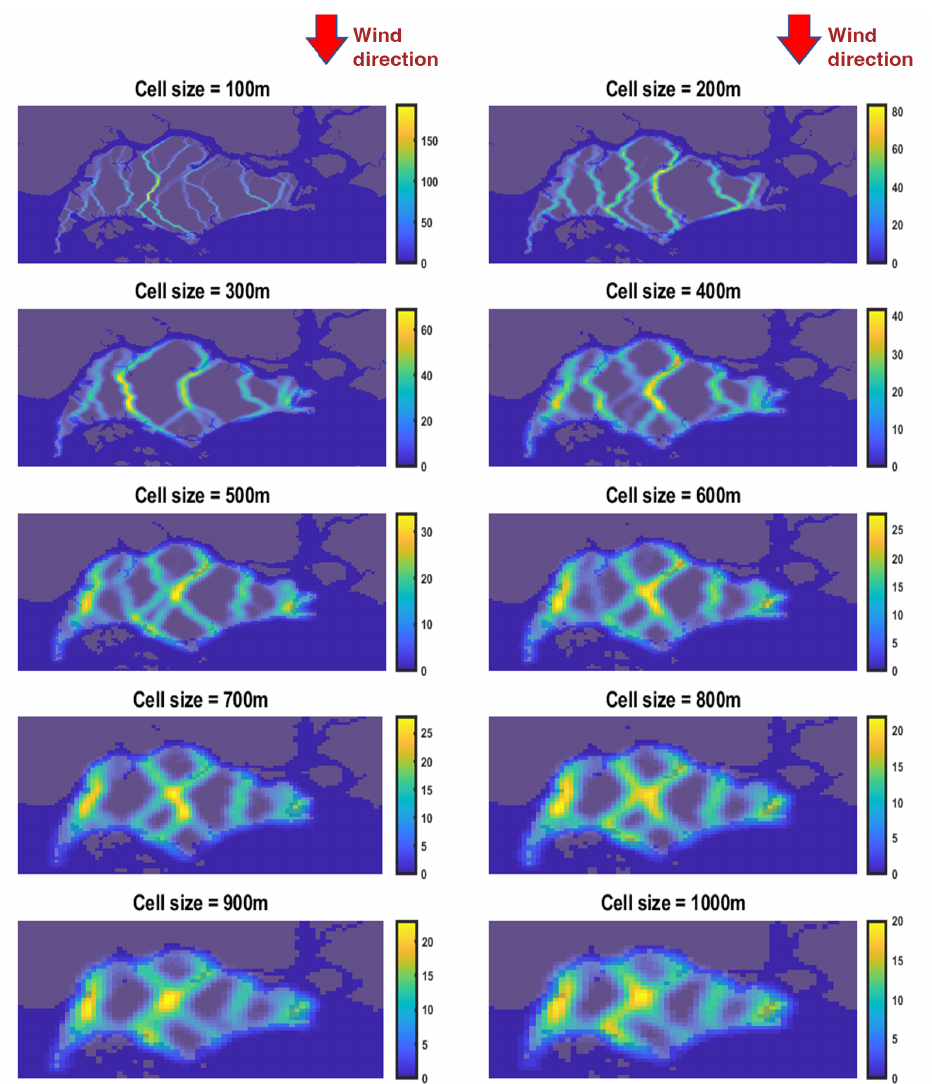
Figure 10. North–south ( θ A = 0) wind corridors for different sizes of